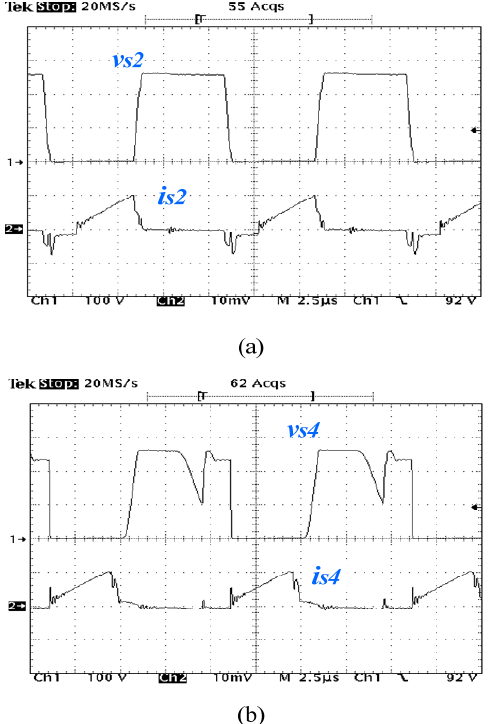
Figure 10. Experiment waveforms of the prototype at E = 260 V, E o = 50 V, I o = 2 A. ( v s .: 100 V/div., i s : 2 A/div., time scale: 2.5 μ s/div). ( a ) Switch S 2 current and voltage ( b ) Switch S 4 current and voltage